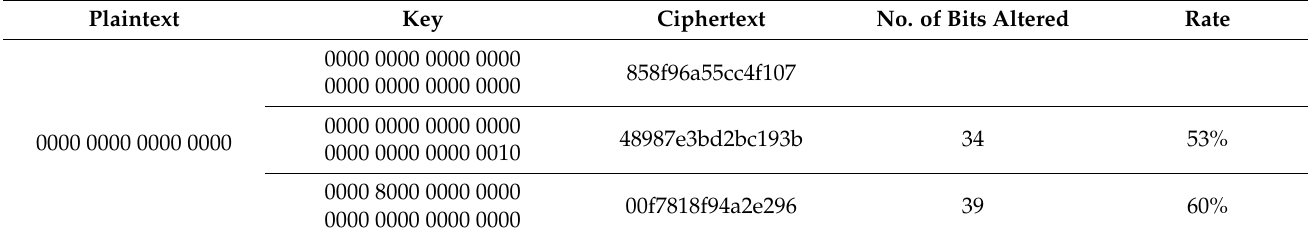
Table 9. The Effect of the Avalanche on SLA-128.